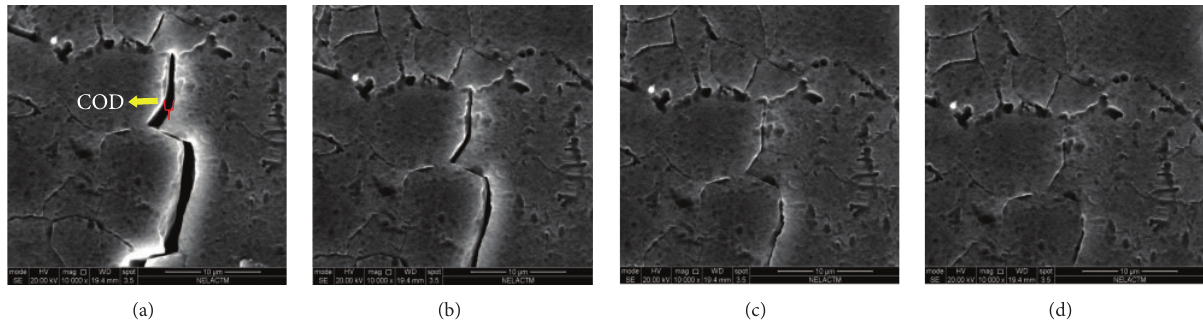
Figure 6: In the unloading stage of 99 cycles, micromorphology of fatigue crack at different loading level: (a) at 1380N, (b) at 960 N, (c) at 750 N, and (d) at 540 N.